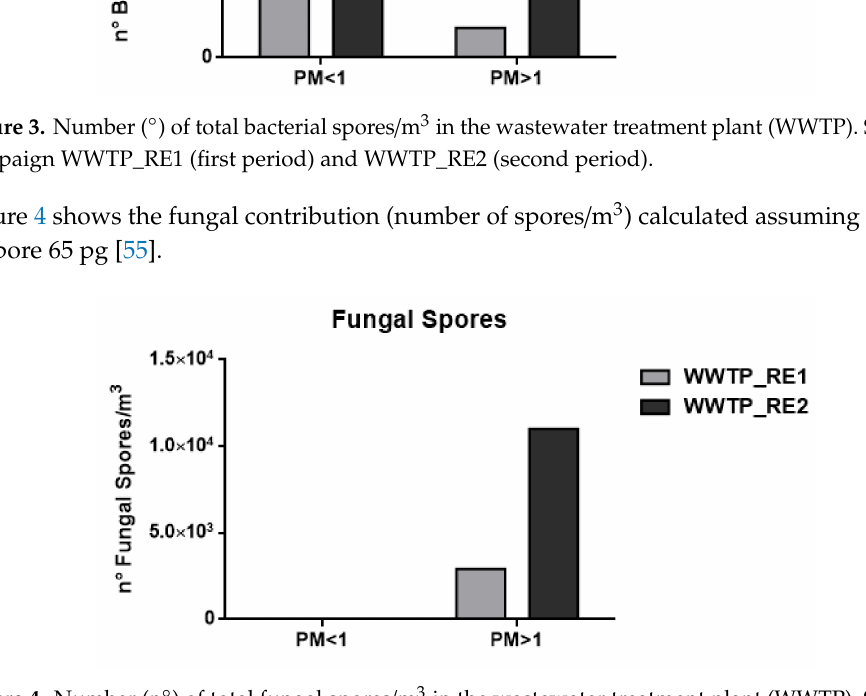
Figure 4. Number (n ◦ ) of total fungal spores / m 3 in the wastewater treatment plant (WWTP). Sampling campaign WWTP_RE1 (first period) and WWTP_RE2 (second